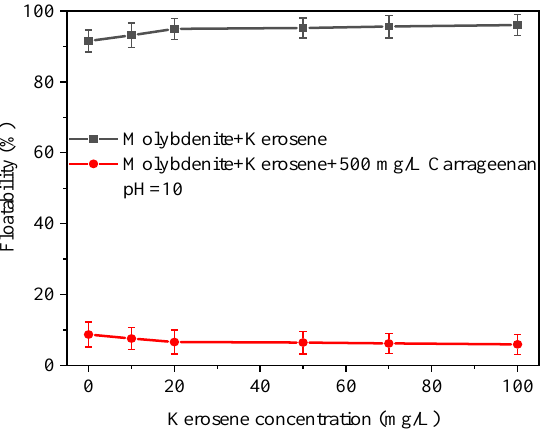
Figure 4. Floatability of molybdenite as a function of kerosene concentration.